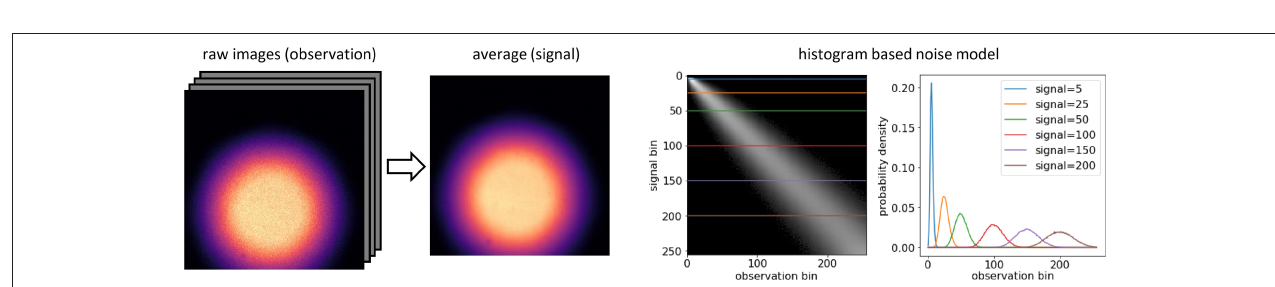
FIGURE 2 | Qualitative results for three images (rows) from the datasets we used in this manuscript. Left to right: raw image (NR1), zoomed inset, predictions by U-Net (trad.), U-Net (N2V), U-Net (PN2V), and ground-truth data.